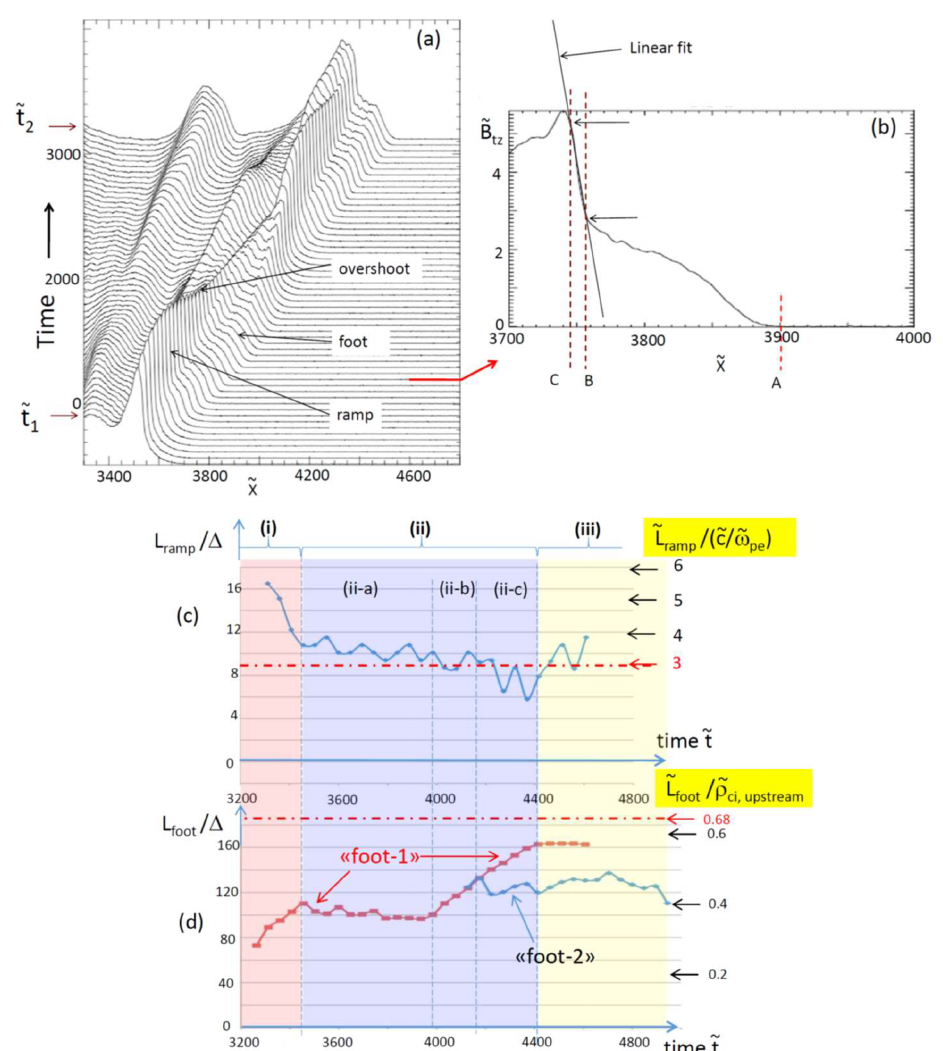
Figure 11. (a) Time stack plot of the main magnetic field component ˜ B tz versus axis ˜ x (the time evolves from the bottom to the top curve, and the propagation of the shock front is along the ˜ x axis from the left to the right-hand side). Results are issued from 2D PIC simulation (where the B 0 static field is out of the simulation plane ˜ x − ˜ y ); the ˜ B tz profile has been space averaged along ˜ y axis; the temporal interval between two successive curves is (cid:49) ˜ t = 48, and the time stack plot covers the time interval 3456 < ˜ t < 6048; (b) blown-up view of the spatial profile of the main magnetic field component ˜ B tz defined at a fixed time ( ˜ t = 4128) indicated by the red arrow in (a) ; the locations of the bounds A, B, and C are illustrated by vertical dashed lines. Time history (c) of the ramp thickness measured within the range BC (defined in b ) normalized versus the upstream electron inertial length c/ω pe (right-hand side scale) and (d) the foot thickness measured within the range AB (defined in b ) normalized versus the upstream ion gyroradius ρ ci (right-hand side scale), during a cyclic self-reformation period ( ˜ τ ref = 1523). In (c) and (d) , the spatial widths are normalized versus the unit space grid (cid:49) on the left-hand side scale. The respective lower- and upper-bound values of the ramp and the foot thickness are reported by dashed–dotted red horizontal lines in (c) and (d) , respectively. Note that the width of ramp-1 is only represented in (c) in order to avoid overwhelming the plot; the small time fluctuations in ramp-1 correspond to error bars of the measurements (which are based on y -averaged ˜ B tz